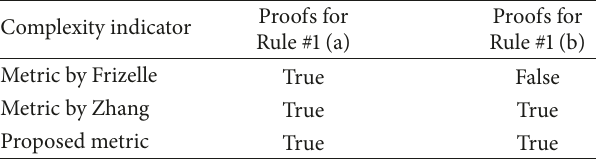
Table 8: Static complexity values and their proof.